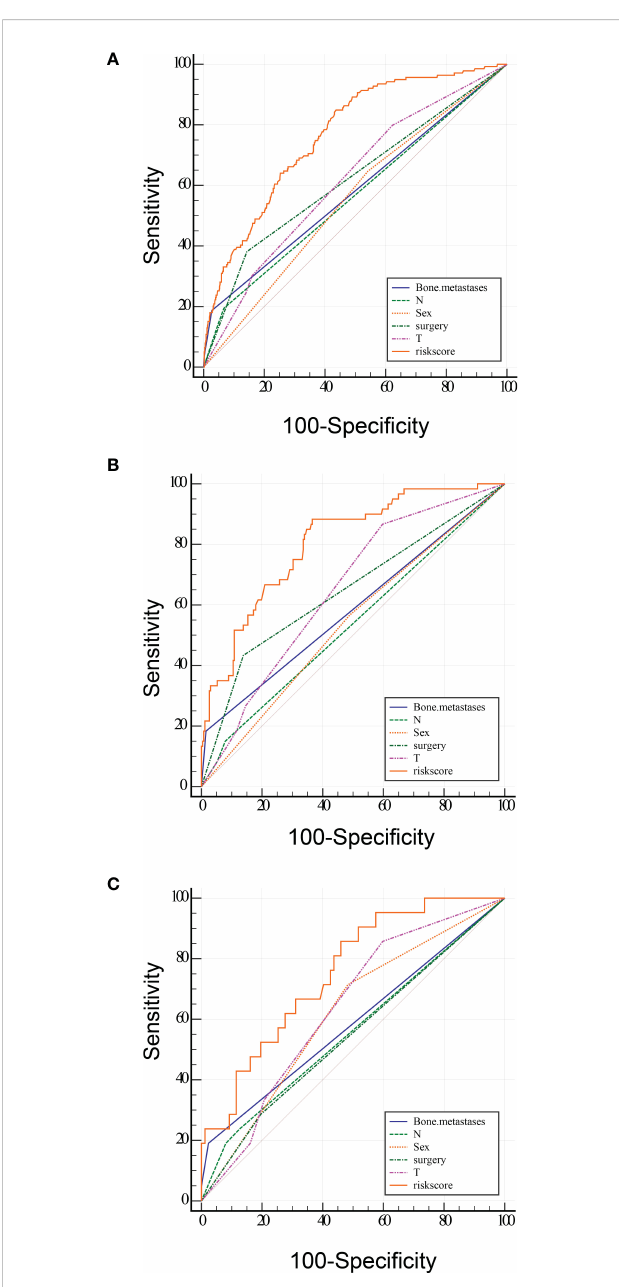
FIGURE 2 ROC curve analysis of the predicted LM nomogram ( A training group, B internal validation group and C multicentre validation group) for indicating the discriminatory ability of the nomogram. The speci fi c AUC values were shown in Table